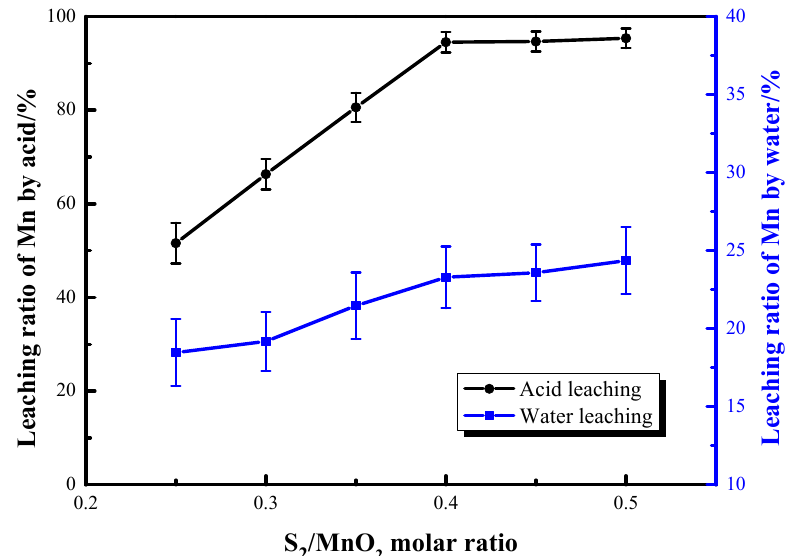
Figure 12. Effect of roasting time on the leaching ratio of Mn (450 °C, S 2 /MnO 2 : 0.5).